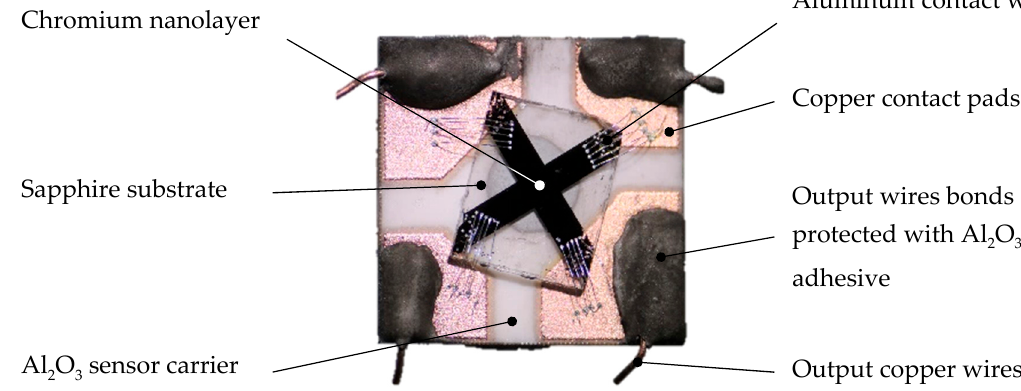
Figure 1. Tested chromium Hall sensor (after testing).